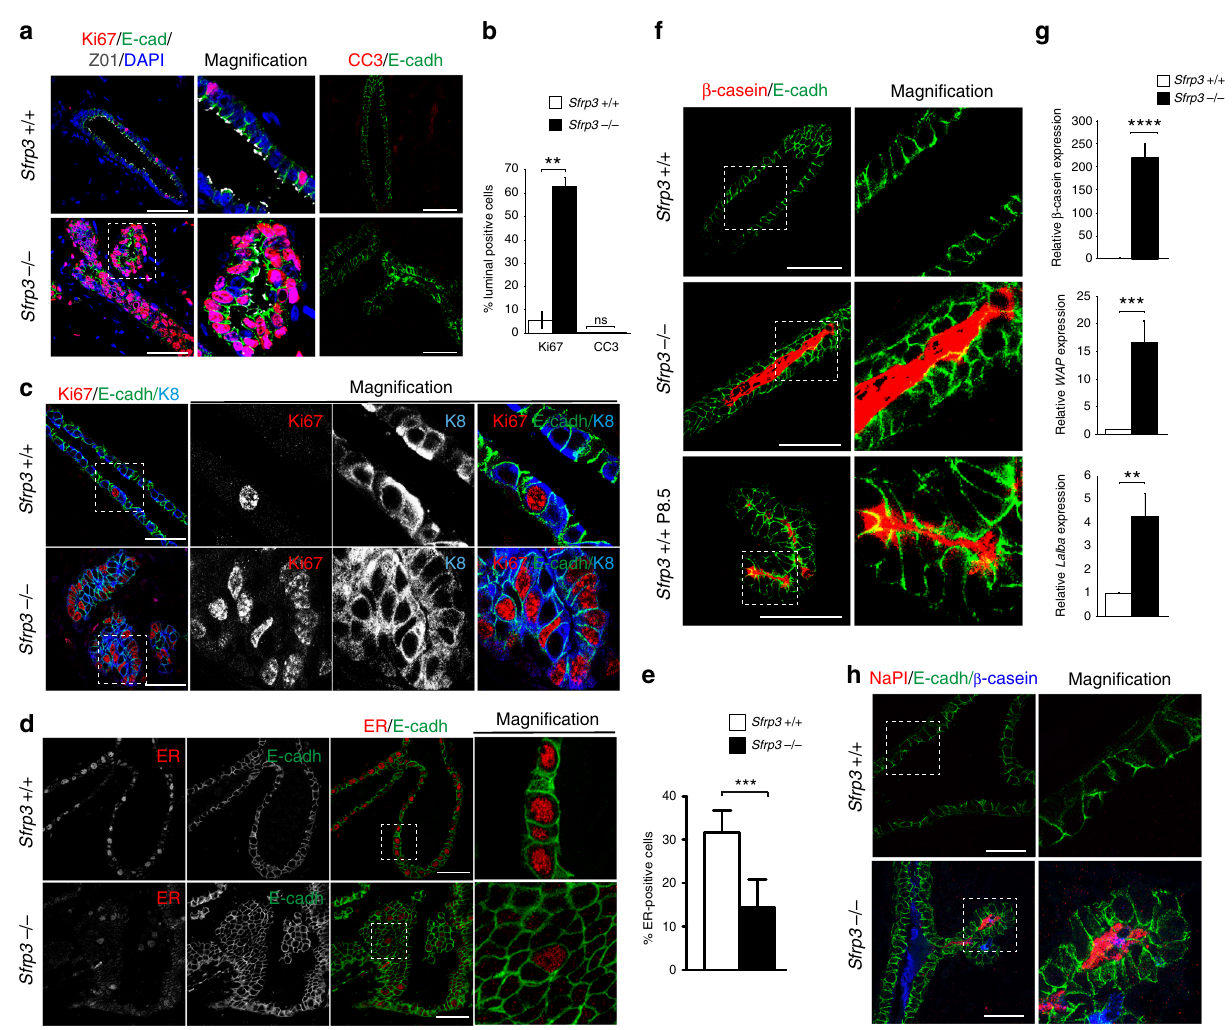
Fig. 3 Increased proliferation and premature differentiation in Sfrp3 − / − MG. a Representative images of immuno fl uorescence staining for Ki67, E-cadherin, ZO1 and DAPI (left and middle) and for Cleaved Caspase 3 (CC3) and E-cadherin (right) on 8 weeks old MGs. Scale bar: 50 µ m. b Quanti fi cation of the number of Ki67 and CC3 positive cells in mammary ducts of 8 weeks old Sfrp3 + / + ( n = 3) and Sfrp3 − / − ( n = 2) females. Data represent mean ± SD (** p < 0.01). c Representative images of immuno fl uorescence staining for Ki67, E-cadherin, Keratin 8 on 8 weeks old mammary glands. Scale bar: 50 µ m. d Representative images of immuno fl uorescence staining for ER (red) and E-cadherin (green), on 8 weeks old mammary glands. Scale bar: 50 µ m. e Quanti fi cation of the number of ER positive cells in mammary ducts of 8 weeks old Sfrp3 + / + ( n = 2) and Sfrp3 − / − ( n = 2) females. Data represent mean ± SD (*** p < 0.001). f Representative images of immuno fl uorescence staining for ß casein and E-cadherin on mammary section from 10 weeks old Sfrp3 + / + and Sfrp3 − / − virgin females and Sfrp3 + / + pregnant females (P8.5). Scale bar: 50 µ m. g Relative mRNA level of ß casein (upper), WAP (middle) and Lalba (bottom) in MGs of Sfrp3 + / + ( n = 3) and Sfrp3 − / − ( n = 4) virgin females at 10 weeks of age. h Representative images of immuno fl uorescence staining for NaPI (red), E-cadherin (green), ß casein (blue) on 8 weeks old MGs. c , h Images are representative of at least 5 MG sections analysed in three different experiments. Data represent mean ± SD (** p < 0.01, *** p < 0.001, **** p < 0.0001). See also Supplementary Fig. 2. Source data are provided as